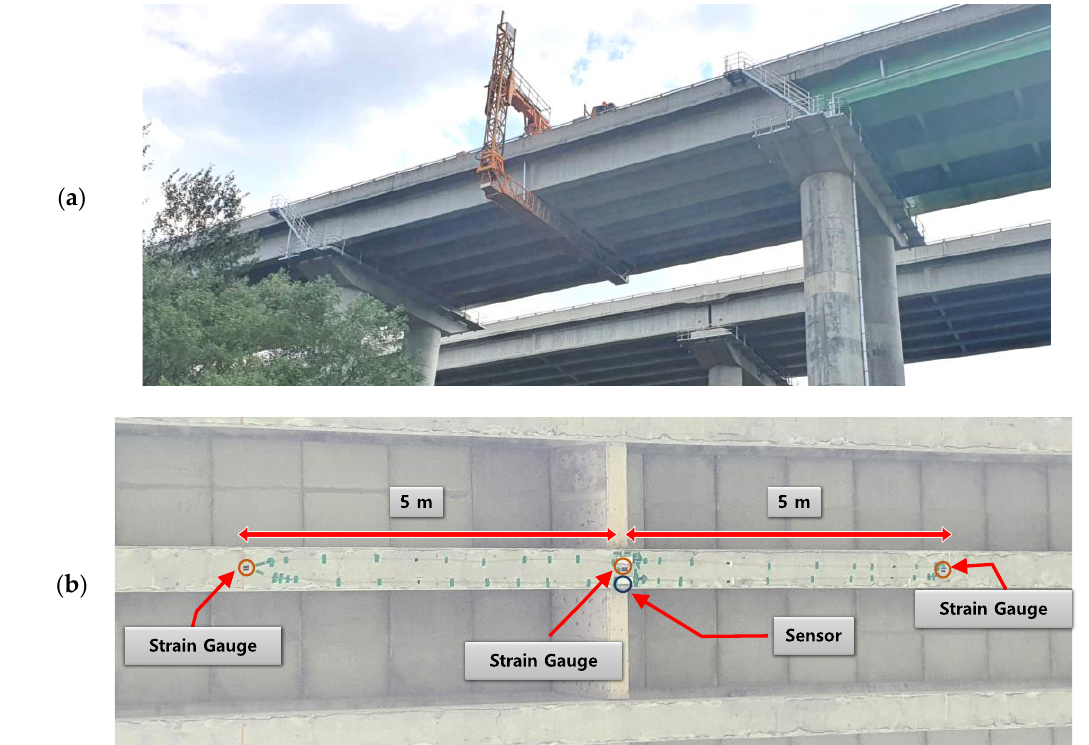
Figure 13. Experimental setup: ( a ) the Geumgok Bridge; ( b ) strain-gauge locations.